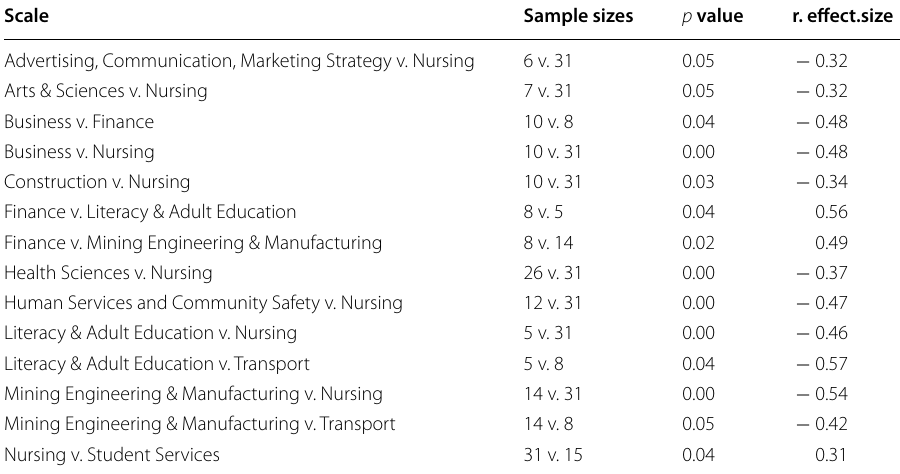
Table 4 Significant comparisons for the culture subscale A between schools in 2019 Scale Sample sizes p value